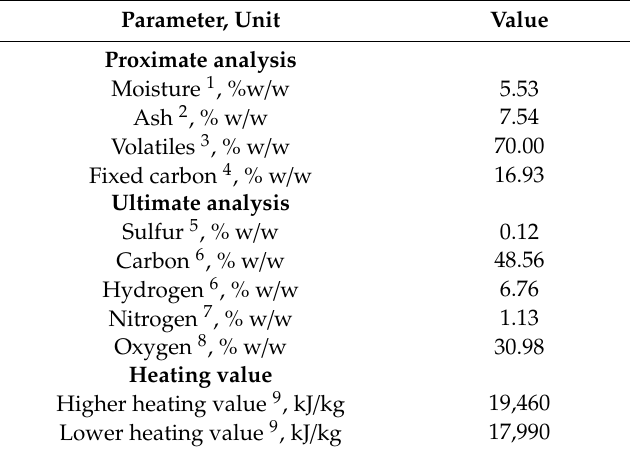
Table 1. Physical and chemical properties of olive